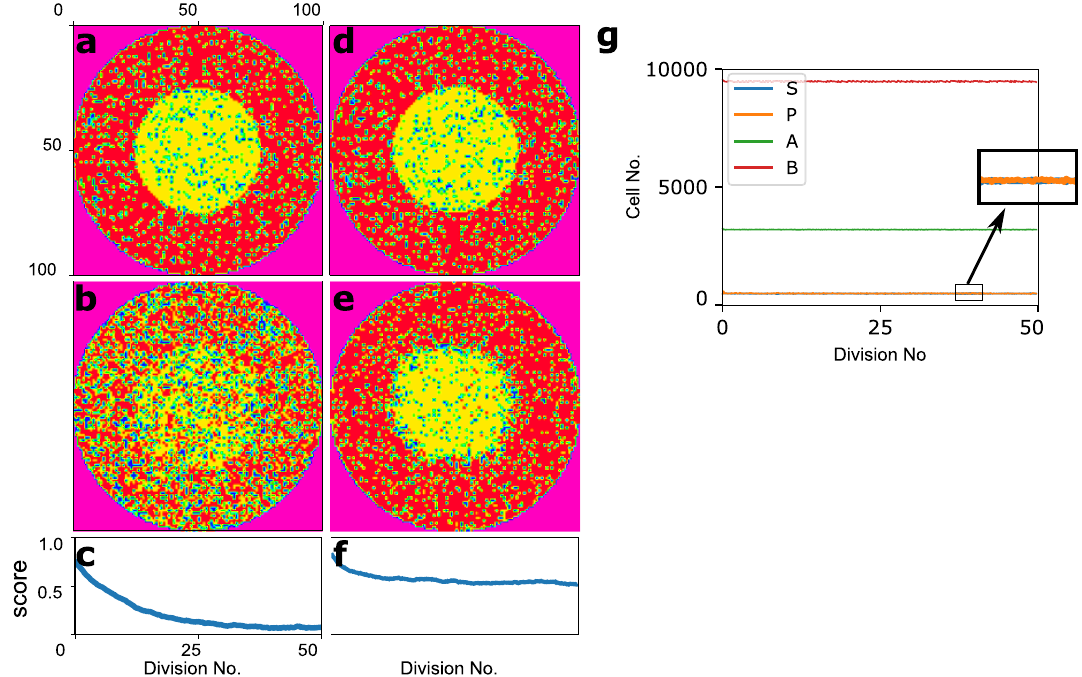
Figure 3. The system behaviour in the absence/presence of inter-cellulat interactions. ( a , d ) The initial state of the system. ( b , e ) The final states of the system in the absence/presence of signalling molecules, in row. ( c , f ) The corresponding score diagrams. ( g ) The maintenance of fours cell types’ abundance through